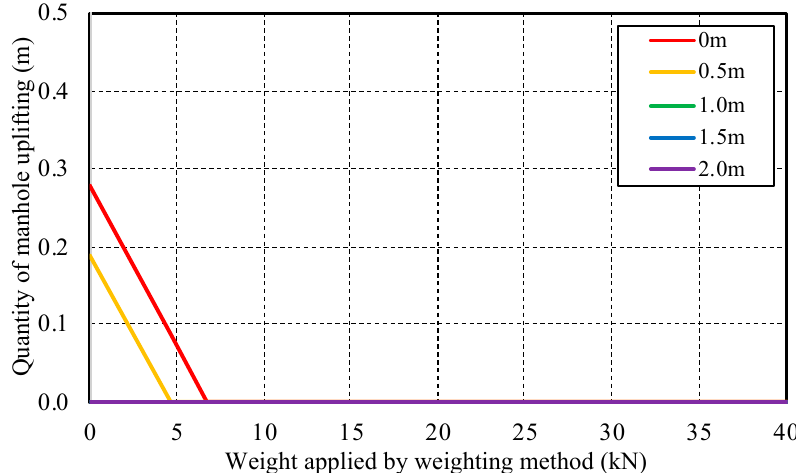
Figure 10. ∆𝑓 for No. 1 circular manhole when groundwater level is changed.